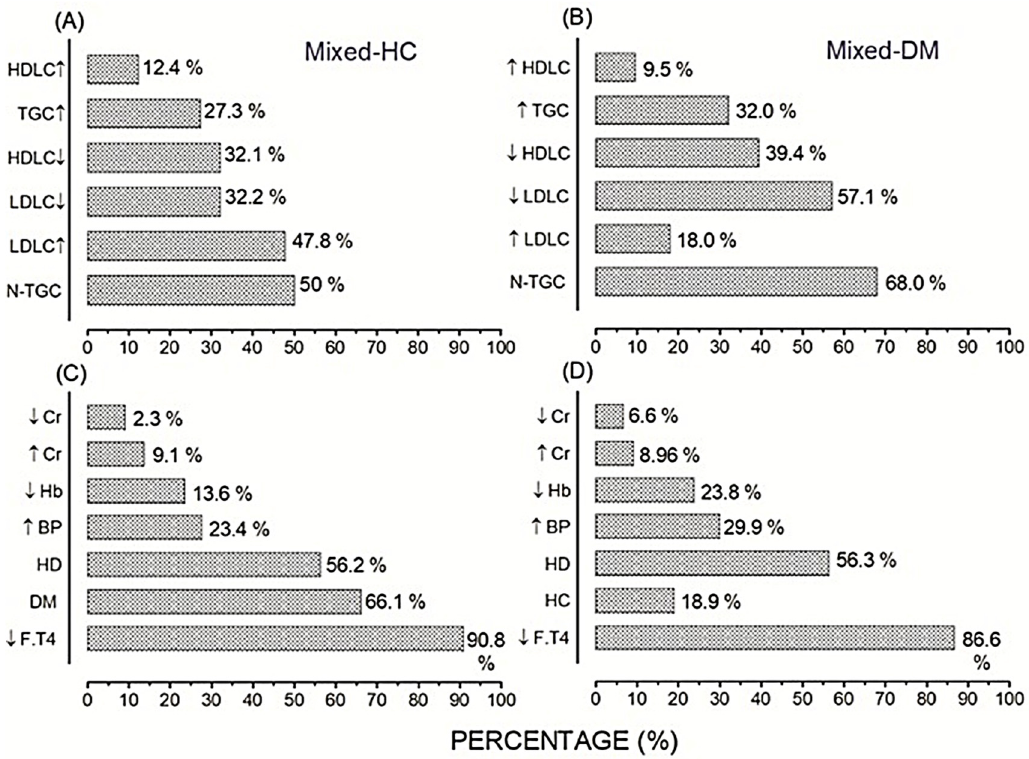
Figure 4. Prevalence of MetS in the mixed–HC ( A , C ) compared to those in the mixed-diabetic ( B , D ) populations. N-TGC denotes the normal triglycerides. Arrows indicated the higher and lower levels of TGC, HDLC, LDLC ( A , B ), F. T4, BP, Hb, and Cr ( C , D ). Table 5. Prevalence of cardiometabolic risk factors in mixed-hypercholesterolemic (HC: ≥ 200